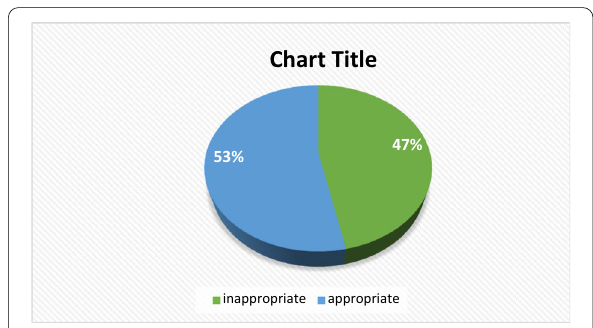
Fig. 2 Post-intervention level of appropriateness